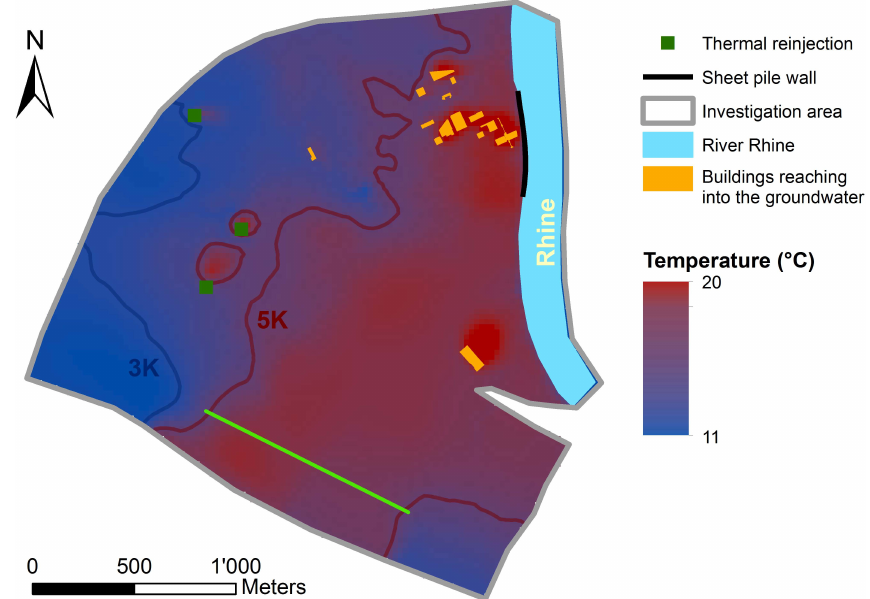
Fig. 7. Calculated temperature distribution for 31 December 2010 in model layer 11. Delineation of areas with temperature increases of < 3K as well as > 5K compared to a “potential natural” state (for explanation refer to the text). Water budgets were calculated through the green